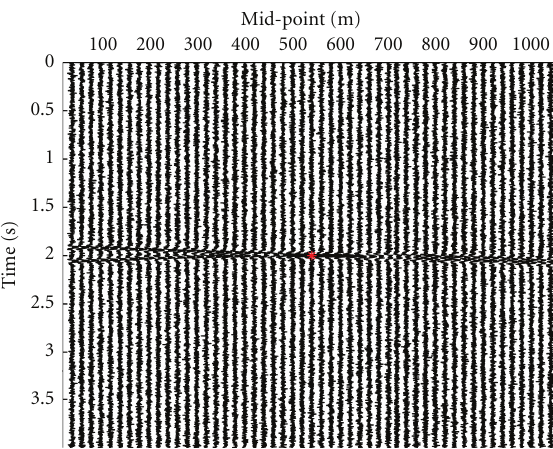
Figure 4: Synthetic ZO section used for comparison of MUSIC with semblance. A point di ff ractor and a dipping reflector ( β = 20 0 ) is used to generate the data. The red dot ( x 0 = 540m and τ 0 = 2sec) shows the location where we performed the parameter